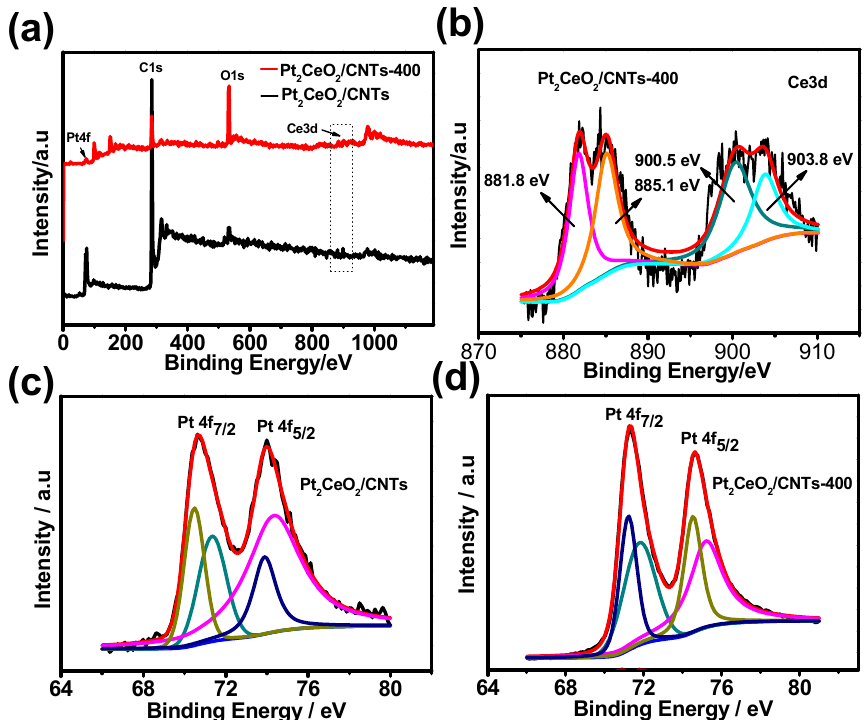
Figure 3. ( a ) XPS survey spectra, ( b ) Ce (3d) spectrum; Pt (3d) spectra of Pt 2 CeO 2 /CNTs ( c ), Pt 2 CeO 2 /CNTs-400 ( d ).